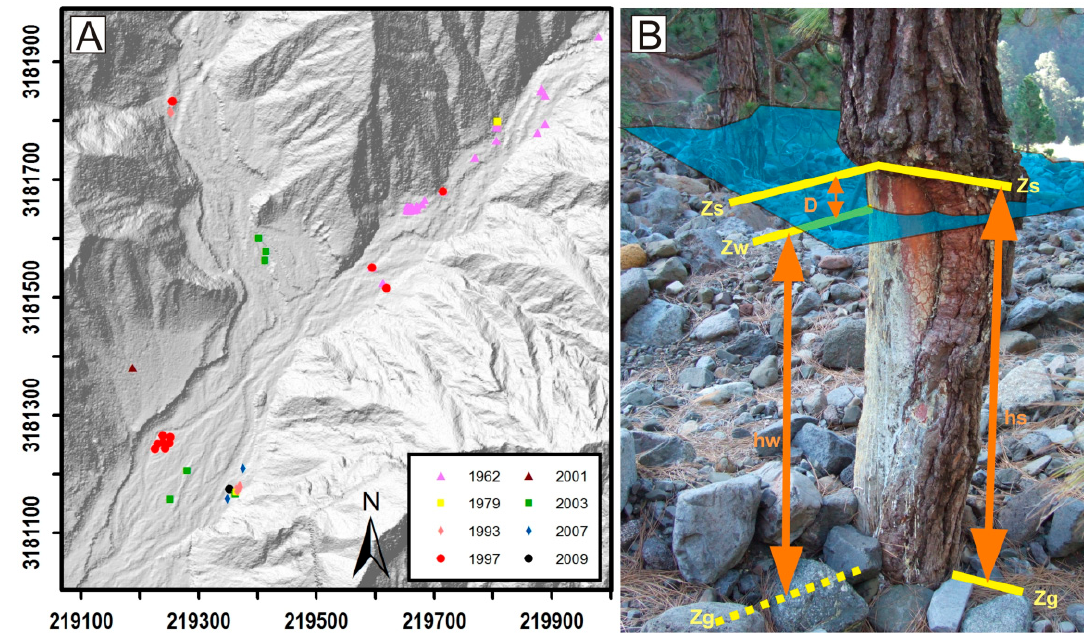
Figure 3. Map location of “Playa de Taburiente” dendro-geomorphological evidence ( A ); x- and y-axis units are meters, according to European Terrestrial Reference System 1989 (ETRS89). Dendro-geomorphological data of interest for hydraulic assessment ( B ). Z s , scar topographic elevation; Z w ,